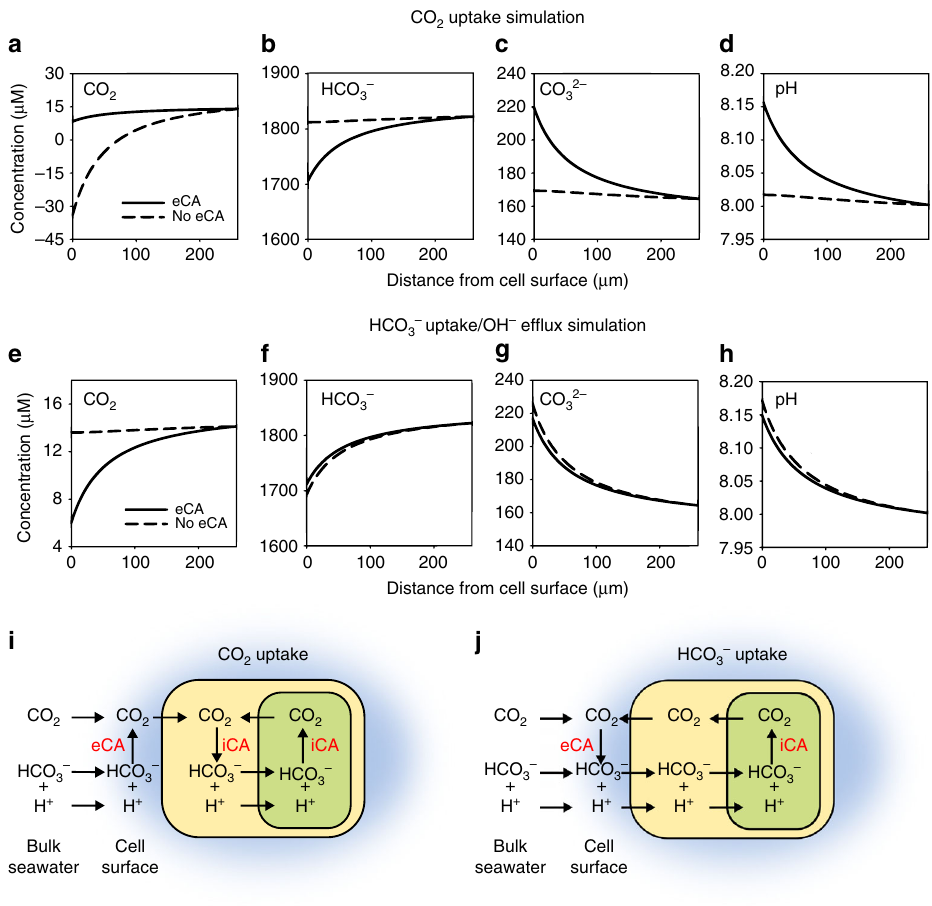
Fig. 2 Cellular modelling of carbonate chemistry around a large diatom cell. Simulated pro fi les of inorganic carbon species (CO 2 , HCO 3 − , CO 3 2 − ) and pH around a large ( r = 60 µ m) photosynthesising cell. The horizontal axis represents distance away from the cell surface. a – d A cell taking up only CO 2 for photosynthesis in the presence (solid line) and absence (dashed-line) of extracellular carbonic anhydrase (eCA). e – h A cell taking up only HCO 3 − for photosynthesis but exporting OH − to maintain internal pH and charge balance. The model shows that eCA is necessary to support substantial rates of CO 2 uptake and that surface pH is dependent on eCA activity only when CO 2 uptake occurs. Note that the model assumes a fi xed rate of CO 2 uptake, which results in a negative value of [CO 2 ] at the cell surface, illustrating that the combination of uncatalysed conversion from HCO 3 − and diffusion is insuf fi cient to supply CO 2 at this rate. The cell size approximates a typical O. sinensis cell and the eCA activity in the model is equivalent to that measured in O. sinensis (8.3 × 10 − 5 cm 3 s − 1 ). i Schematic illustration of the major DIC and H + fl uxes during CO 2 uptake. eCA catalyses the conversion of HCO 3 − to CO 2 at the cell surface (consuming H + ) to maintain the inward concentration gradient for CO 2 . iCA intracellular carbonic anhydrase. j DIC and H + fl uxes during active HCO 3 − uptake. In this scenario, eCA could act to minimise CO 2 loss from the cell, converting CO 2 leaking across the plasma membrane to HCO 3 − (generating H + ). For simplicity, the schematic shows H + uptake co-occurring with HCO 3 − uptake, although OH − ef fl ux was used in the cellular